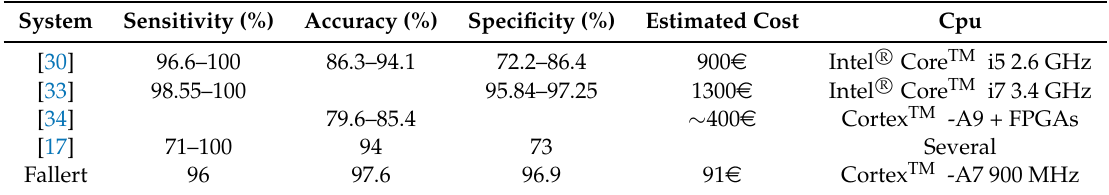
Table 3. Fall detection system